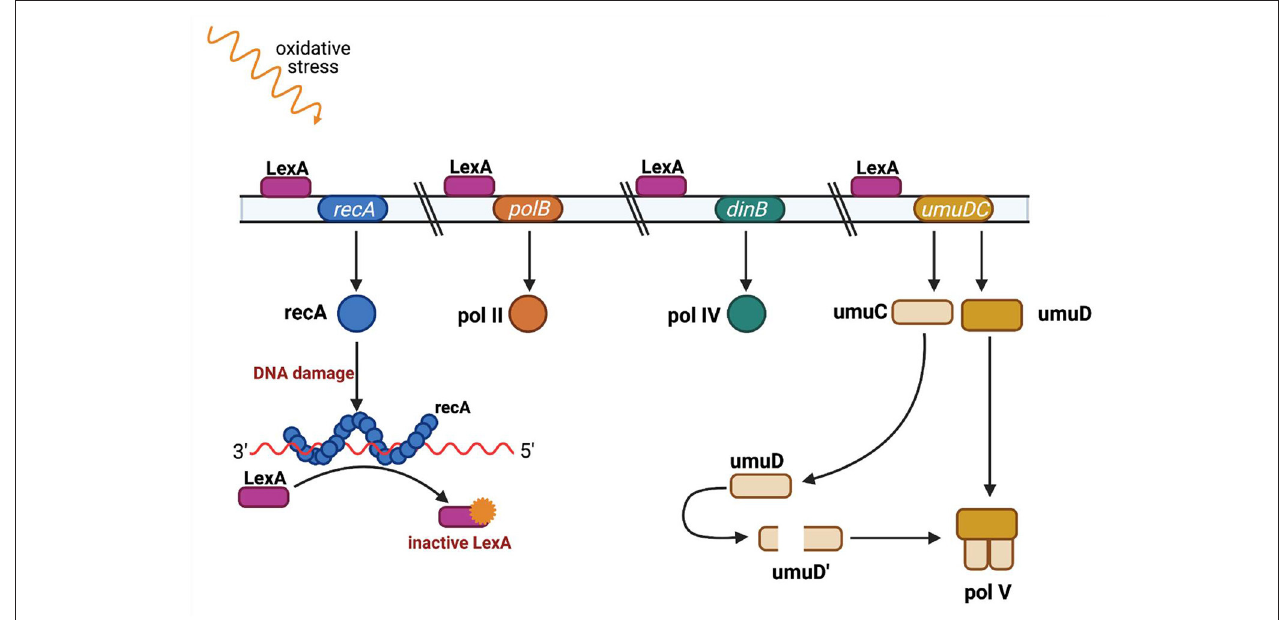
FIGURE 4 | SOS regulation. The LexA protein is attached to an operator upstream of the SOS response genes and blocks their transcription. Single-stranded DNA fragments (ssDNA) accumulate when DNA is damaged (eg. as a result of UV radiation or ciprofloxacin). RecA protein binds to single-stranded DNA fragments to form nucleoprotein fibers that stimulate the SOS response. The active form of RecA protein interacts with the LexA repressor and causes LexA to dissociate from the operator. When LexA is not attached to an operator, genes responsible for DNA repair are transcribed, such as polB gene encoding polymerase II, dinB gene encoding polymerase IV, and the umuC and umuD genes encoding proteins UmuC and UmuD, which are subunits of polymerase V. Polymerases IV and V replicate damaged DNA. Adapted from Tropp (31). (Created with